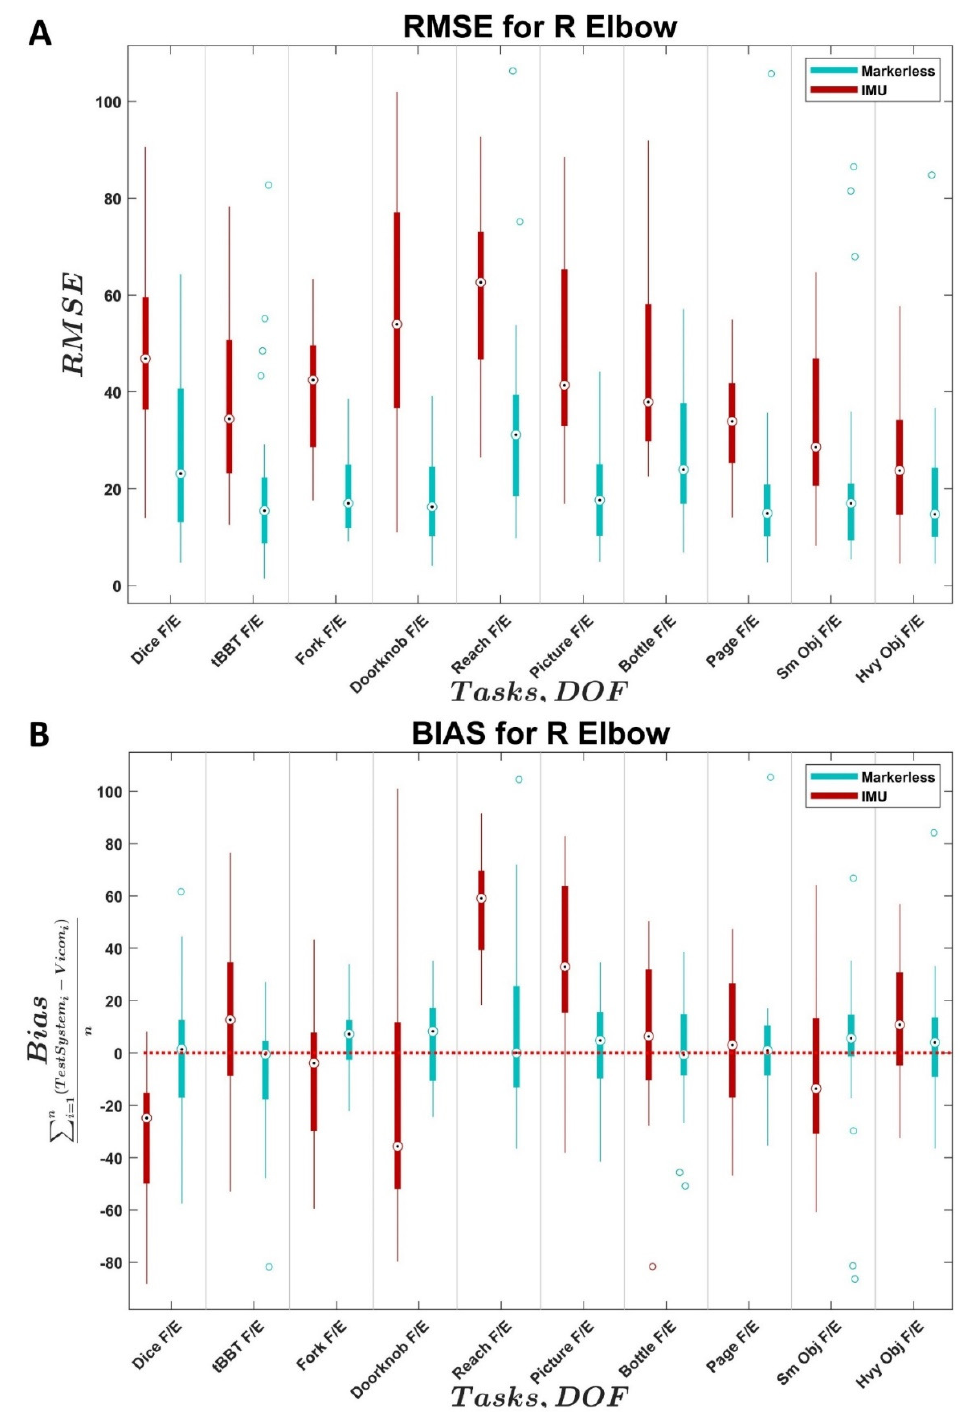
Figure 2. Distributions of ( A ) right elbow flexion RMSE and ( B ) right elbow flexion bias across subjects for the IMU system (Xsens Awinda MTw, El Segundo, CA) and markerless system (Kinect, Microsoft, Seattle, WA, USA) compared to the reference system (VICON, Oxford, UK). X-axis identifies the task and associated joint angle. F/E = flexion/extension, Ab/Ad = abduction/adduction, LaF = lateral flexion, Rot = rotation. Black dots indicate medians, empty circles indicate outliers, bold line indicates quartiles, and whiskers indicate non-outlier maximums and minimum.